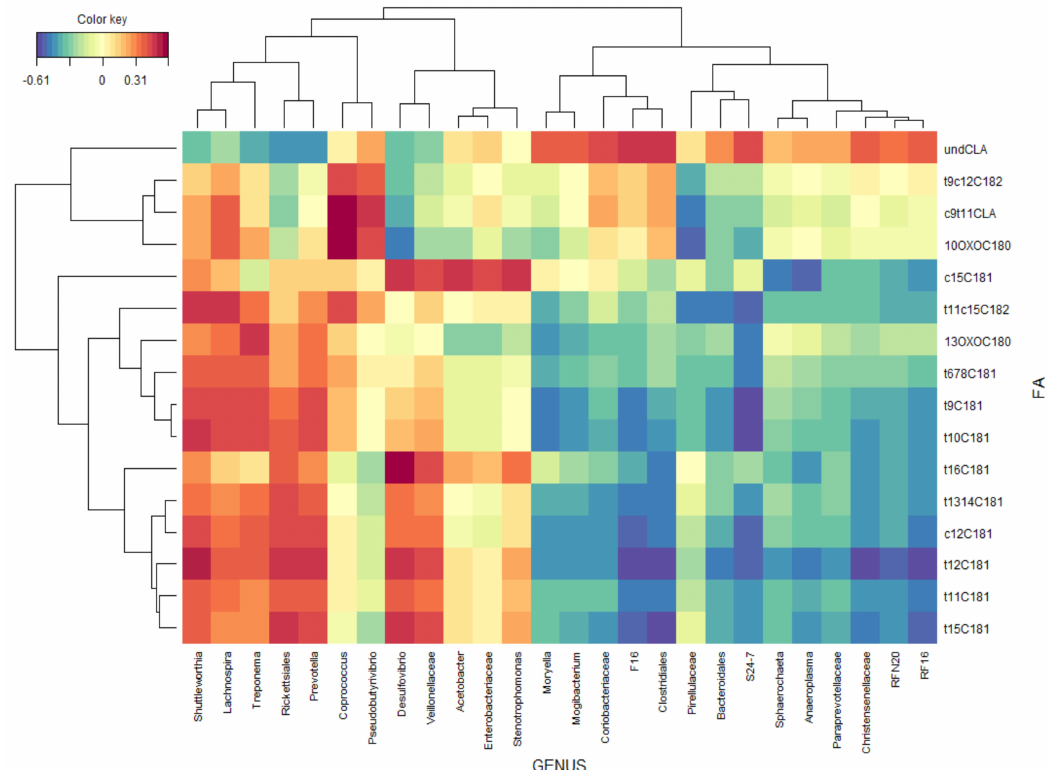
Figure 3. The relationships between clusters of bacterial genus and rumen fatty acids independent of treatment. This clustered image map was based on the regularized canonical correlations between relative bacterial abundances and relative concentrations of rumen fatty acids. Significant correlations are colored following the key